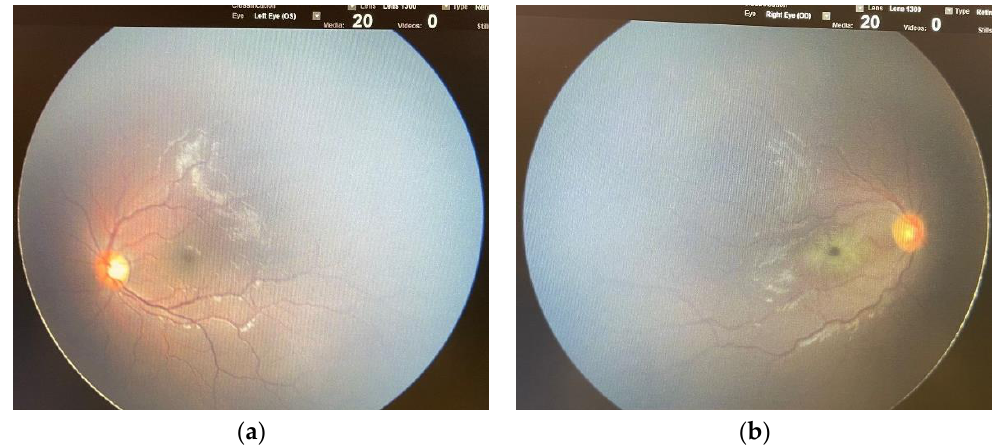
Figure 3. Fundus examination in a six-year-old girl with central retinal artery occlusion (CRAO) during COVID-19 (with kind concession of P. Fortunato MD). ( a ) Normal fundus in the left eye. ( b ) In the right eye characteristic funduscopic findings of CRAO: retinal whitening, cherry red spot in the fovea and filiform retinal arteries.